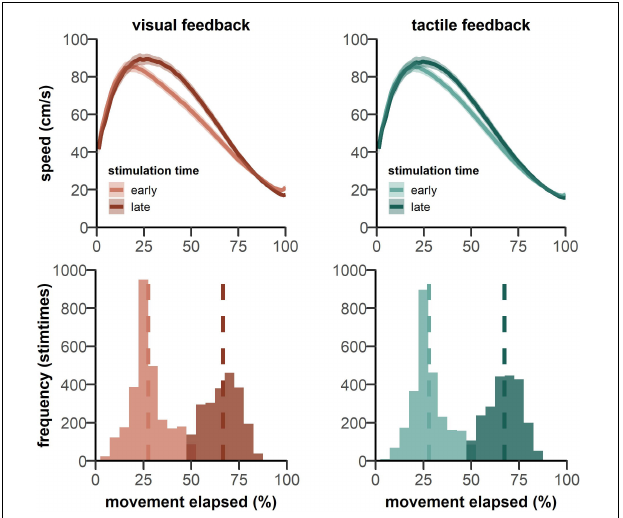
FIGURE 5 | (top panels) Show the mean movement speed across trial time, starting from the go signal. Data is plotted separately for both feedback types pooled over both groups. Participants show an earlier reduction in movement speed when the probing stimulus was delivered in the early phase of the movement (lighter colored lines). Shaded patches indicate standard error of the mean. (lower panels) Show the frequency of stimulation times over all trials. The dashed lines show the mean stimulation time for each